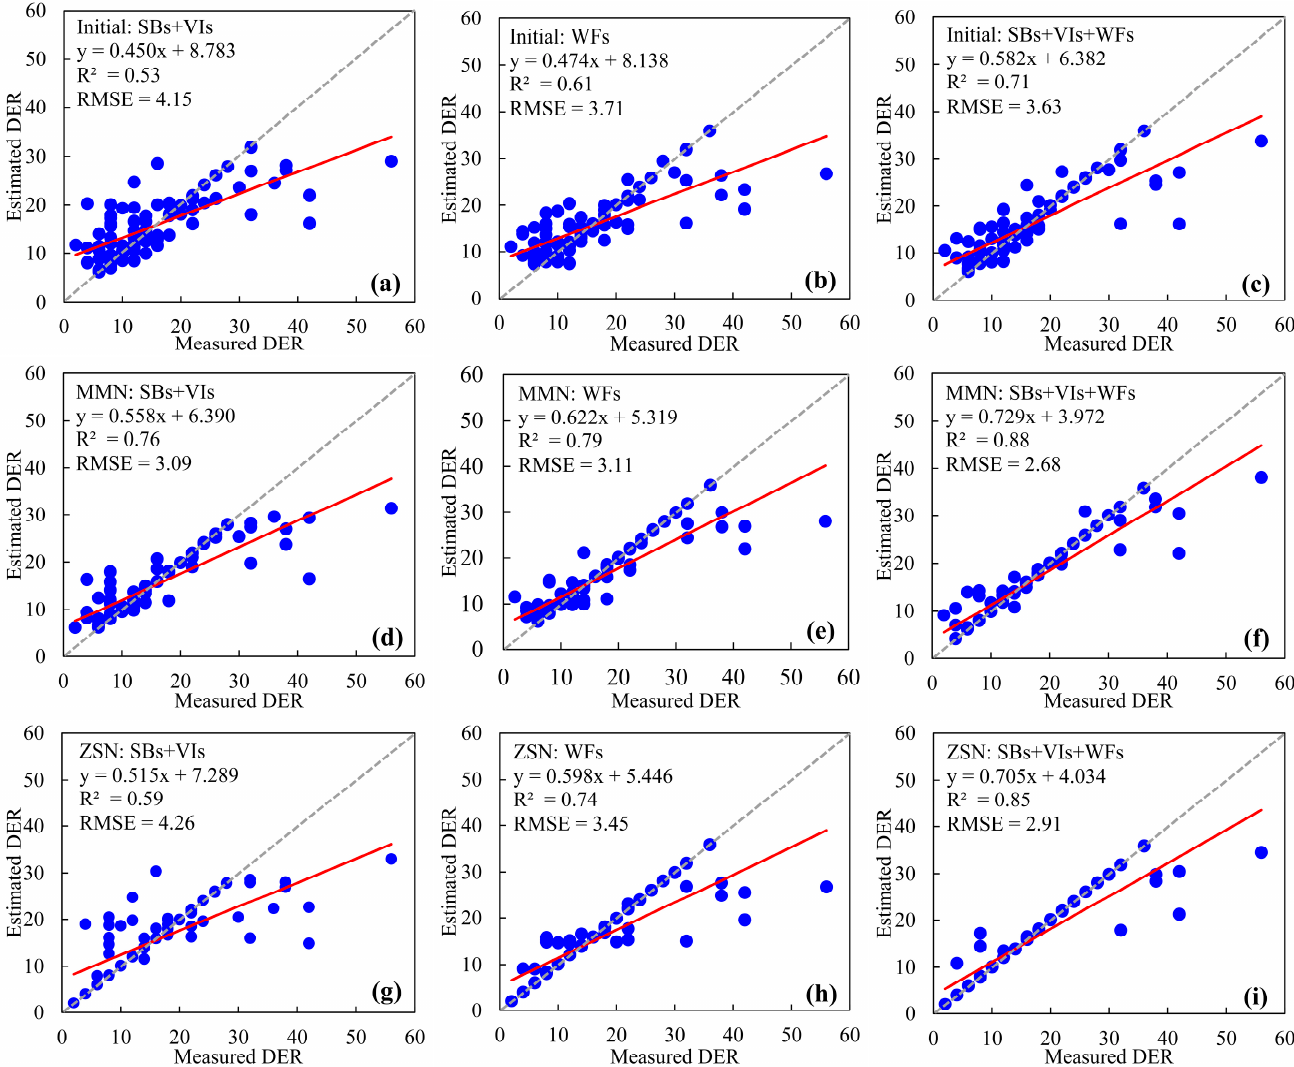
Figure 5. Scatter plots of measured DER versus estimated DER of SVM detection models based on ( a – c ) initial spectral feature combinations of SBs, VIs, and WFs; ( d – f ) spectral feature combinations of SBs, VIs, and WFs normalized using MMN algorithm; and ( g – i ) spectral feature combinations of SBs, VIs, and WFs normalized using ZSN algorithm.